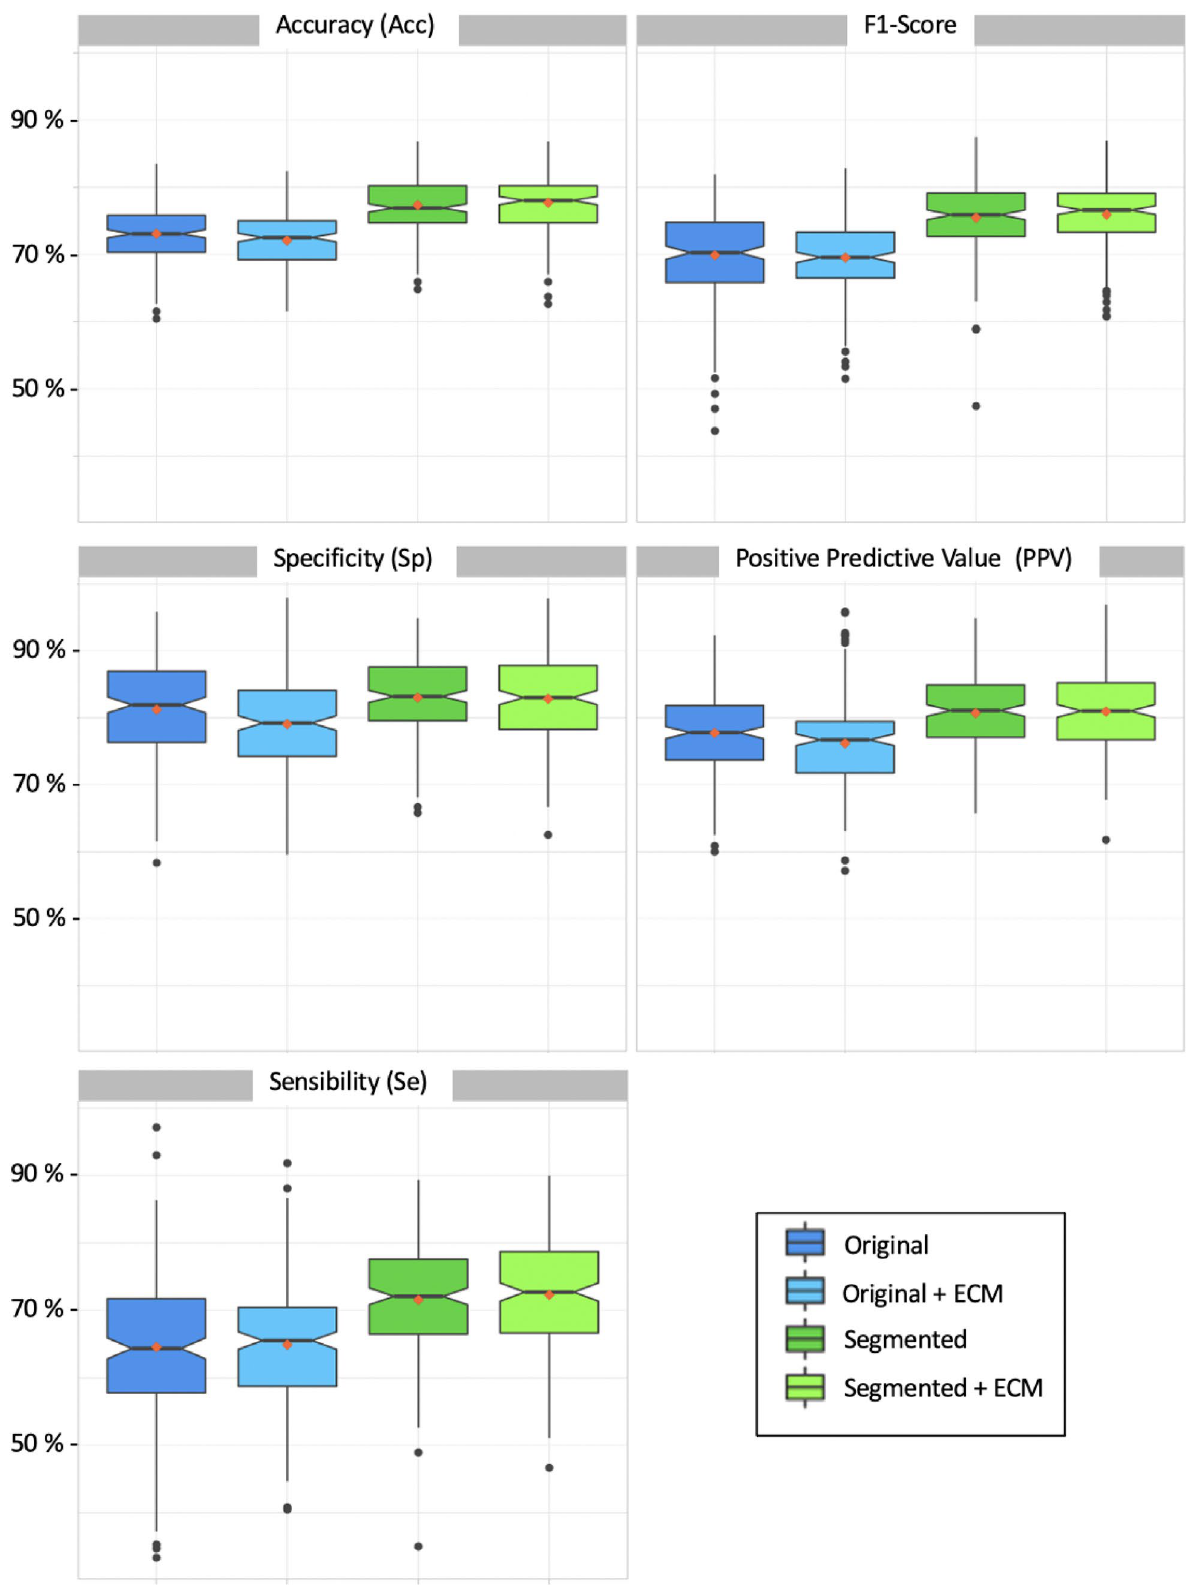
Figure 1. Metrics achieved over the 200 validation sets with the four pre-processings. Notched box plots the medians are represented by the thickest black horizontal lines framed by a notch which represents the 95% Confident Interval of the median. The red dots correspond to the means and the black dots represent the outliers which are values numerically distant from the rest of the